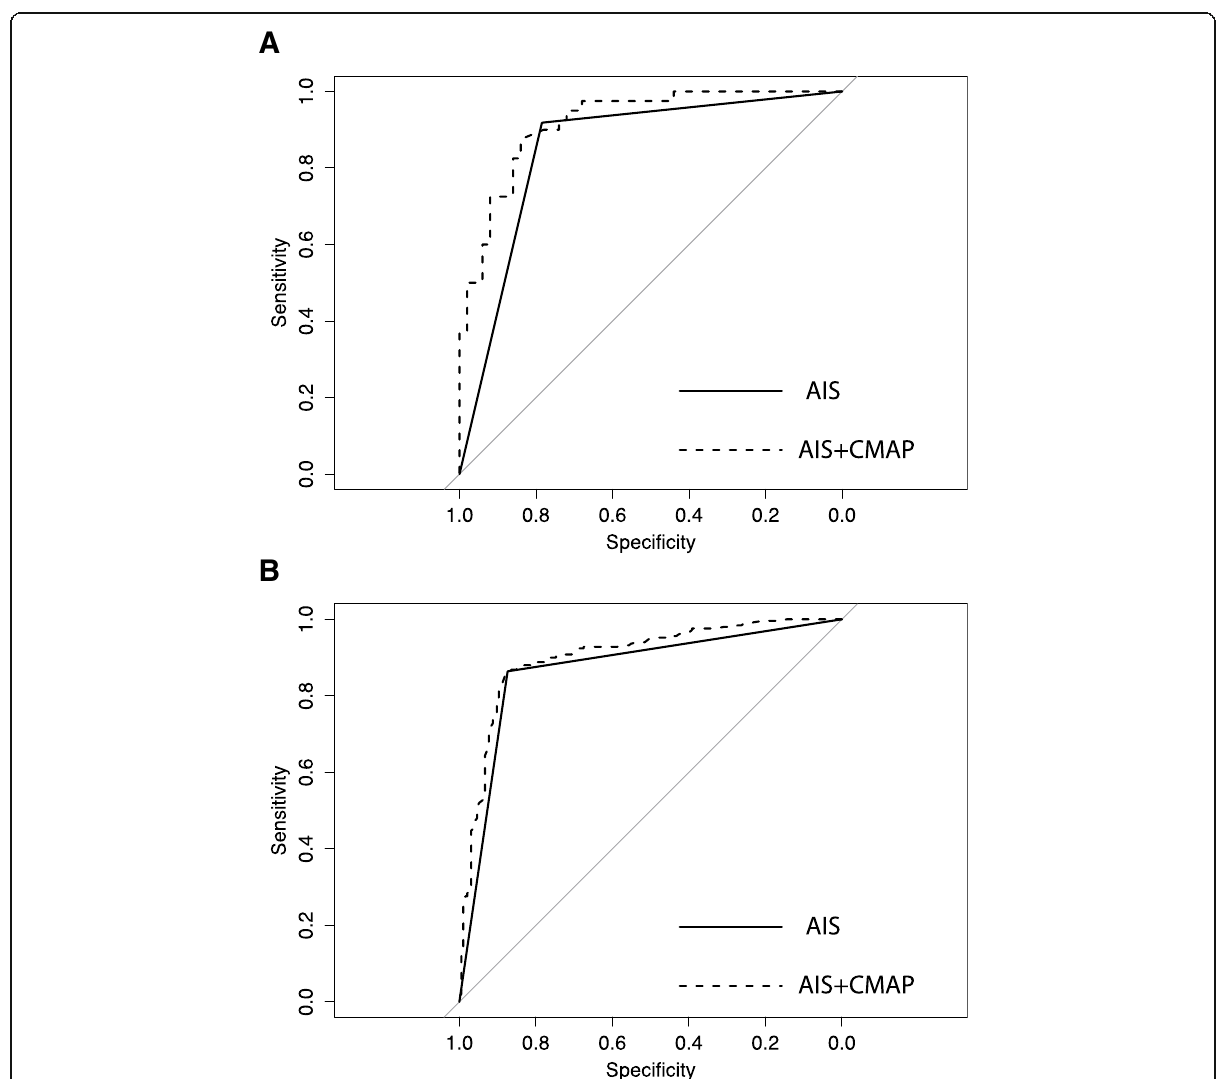
Fig. 3 ROC curve analysis of logistic regression results. The solid line represents the logistic fit of the initial AIS (within first 4weeks) for the prediction of good recovery AIS D versus A-C. The dashed line represents the logistic model fit of initial AIS+initial right ulnar nerve CMAP amplitude. The improved prediction accuracy of the full model (initial AIS+initial CMAP) versus initial AIS alone is significant in the EMSCI-HD ( a ) and EMSCI-nonHD ( b ) cohorts, respectively ( p =0.0017 and 0.0003). Complete-case analysis. (EMSCI-HD cohort n =90; EMSCI-nonHD cohort n